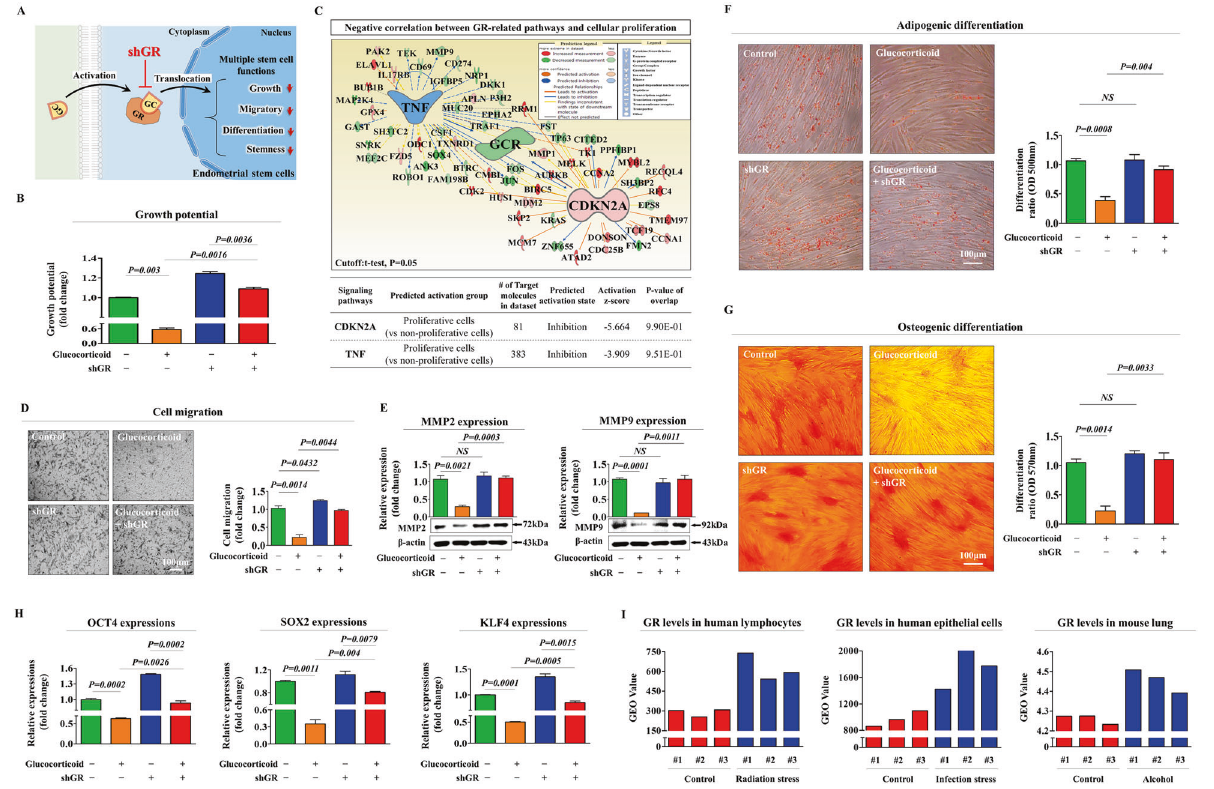
Fig. 3 Glucocorticoids exert diverse effects on various regenerative capacity-related functions through their cognate receptors. A schematic diagram regarding the functional role of GR in mediating glucocorticoid-induced effects is shown ( A ). Endometrial stem cells were cultured with 500 nM glucocorticoid alone or were concomitantly transfected with a speci fi c shRNA targeting GR, and subsequent changes in cell proliferation were measured with MTT assays ( B ). Differentially expressed genes in proliferative cells and nonproliferative cells (GSE62564) were investigated by IPA software to assess the activation states of various GR-related pathways/transcription factors ( C ). The suppressive effects of GR depletion on glucocorticoid-induced changes in migratory capacity were also determined by Transwell assays ( D ) and western blotting for MMP-2 and MMP-9 ( E ). The attenuating effects of GR knockdown on the ability of glucocorticoids to suppress adipogenic ( F ) and osteogenic ( G ) differentiation were measured by oil red O staining and alizarin red staining, respectively. The attenuating effects of GR depletion on the expression of the pluripotency-related transcription factors KLF4, OCT4, and SOX2 were determined by real-time PCR ( H ). The GEO database (https://www.ncbi.nlm.nih.gov/geo/) was investigated to analyze the relationship between various physiological conditions and GR expression levels ( I ). β -actin was used as an internal control. PPIA was used as a housekeeping gene for real-time PCR analysis. All experiments were performed in triplicates, and the data has been presented as mean ± standard deviation (SD). P -value under 0.05 was presented in fi